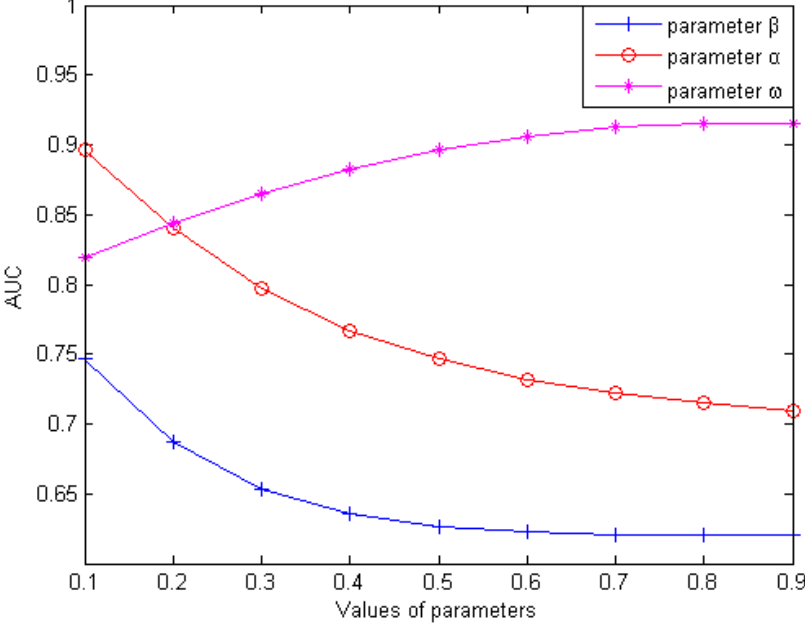
Figure 1. Influence of parameter variation on model prediction accuracy.